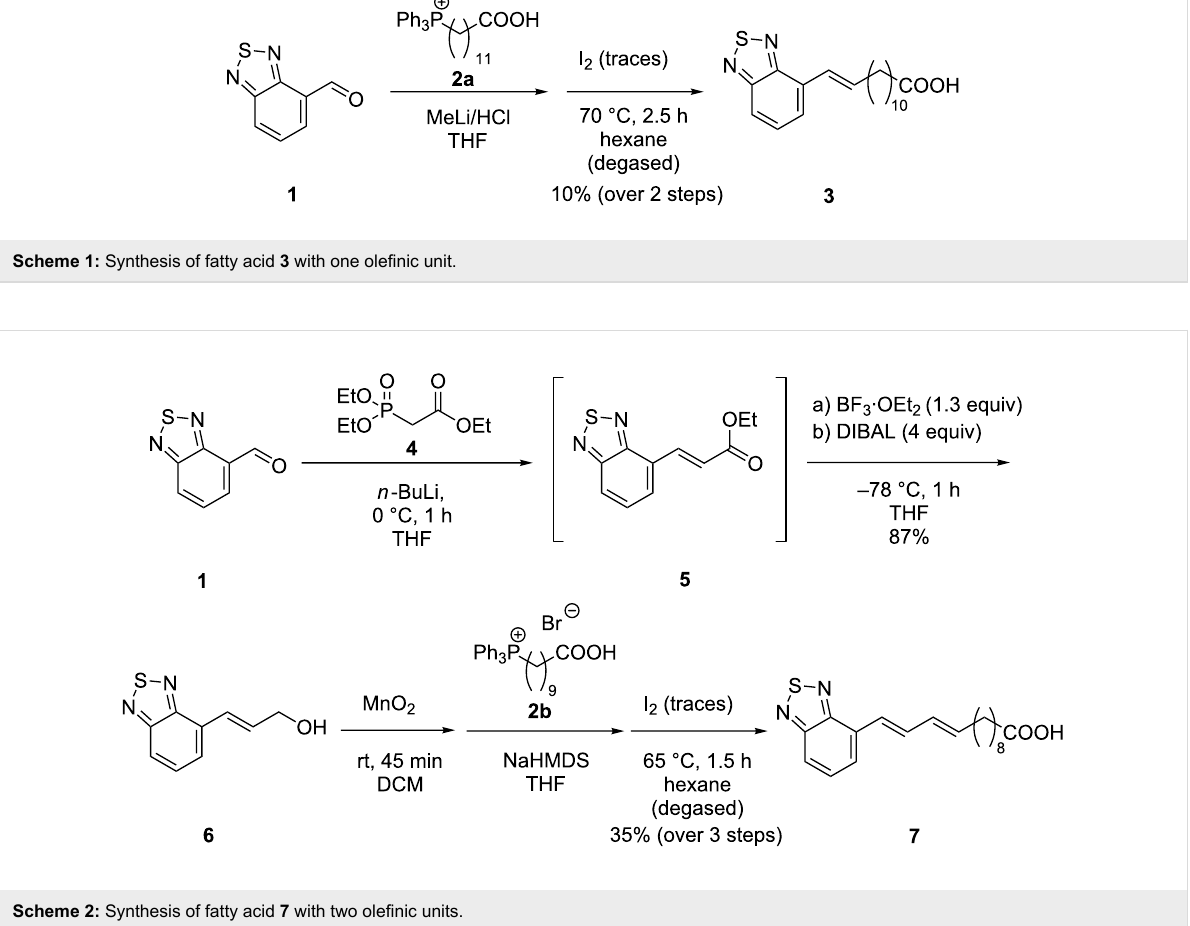
Scheme 2: Synthesis of fatty acid 7 with two olefinic